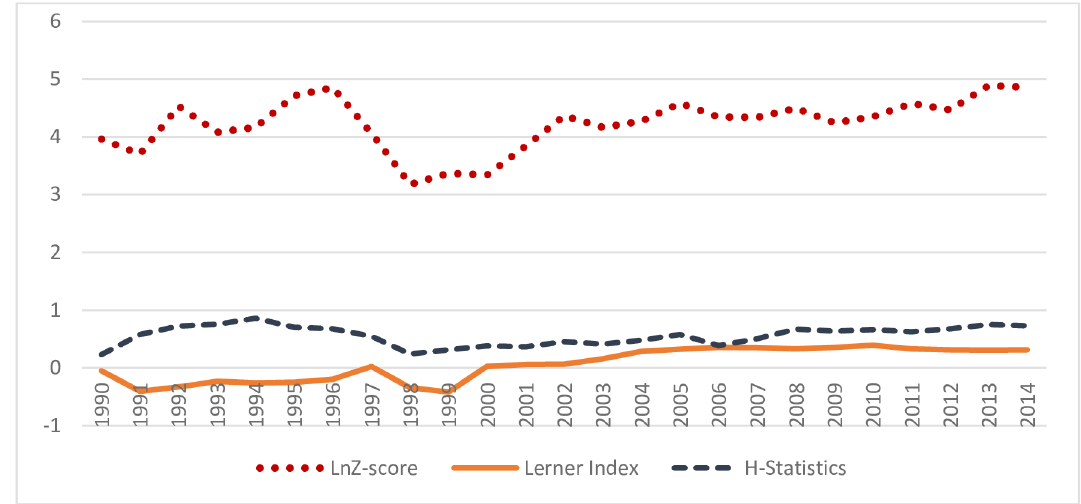
Fig 1. Co-movement of lnZ-score, H-statistic and Lerner Index in ASEAN- 5 during 1990–2014 period. Note: Fig 1 presents co-movement lnZ-score, H-statistic and Lerner index in ASEAN-5 from 1990 to 2014. ASEAN-5 includesIndonesia, Malaysia, the Philippines, Singaporeand Thailand.Definitionof lnZ-score, H-statistic and Lerner index, and source of their data collectionare presented in S1 Table.